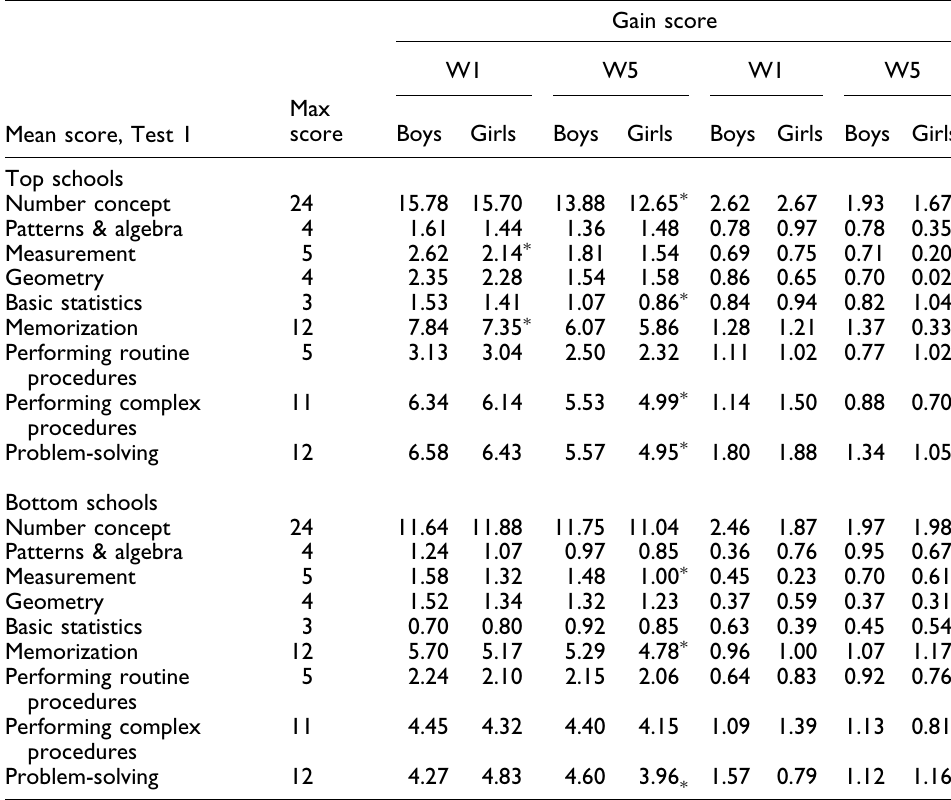
Table 2. Gender differences in maths performance within the lowest and highest wealth quintiles.